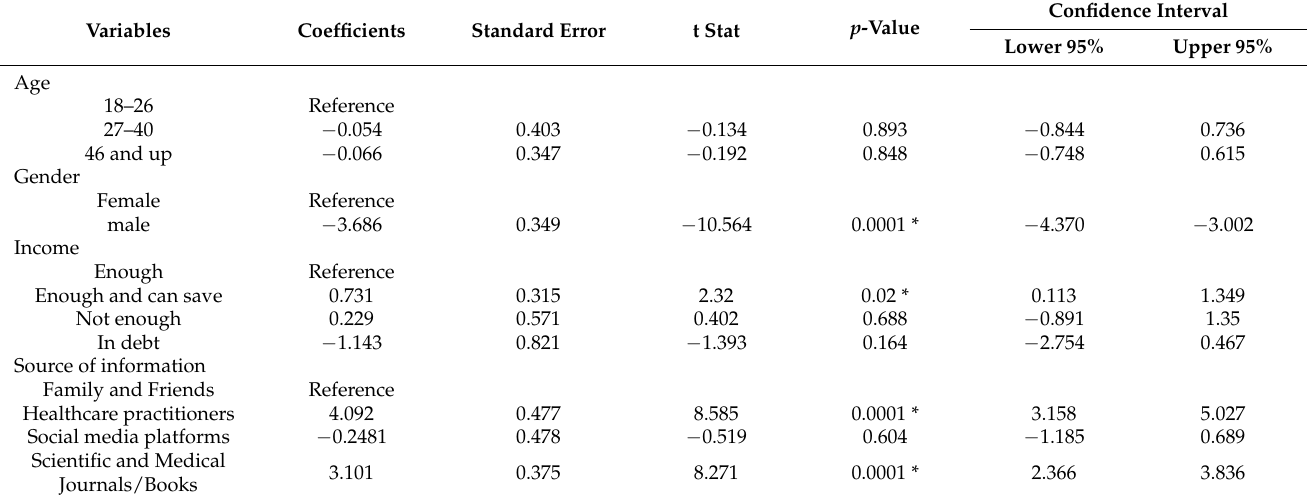
Table 4. Regression